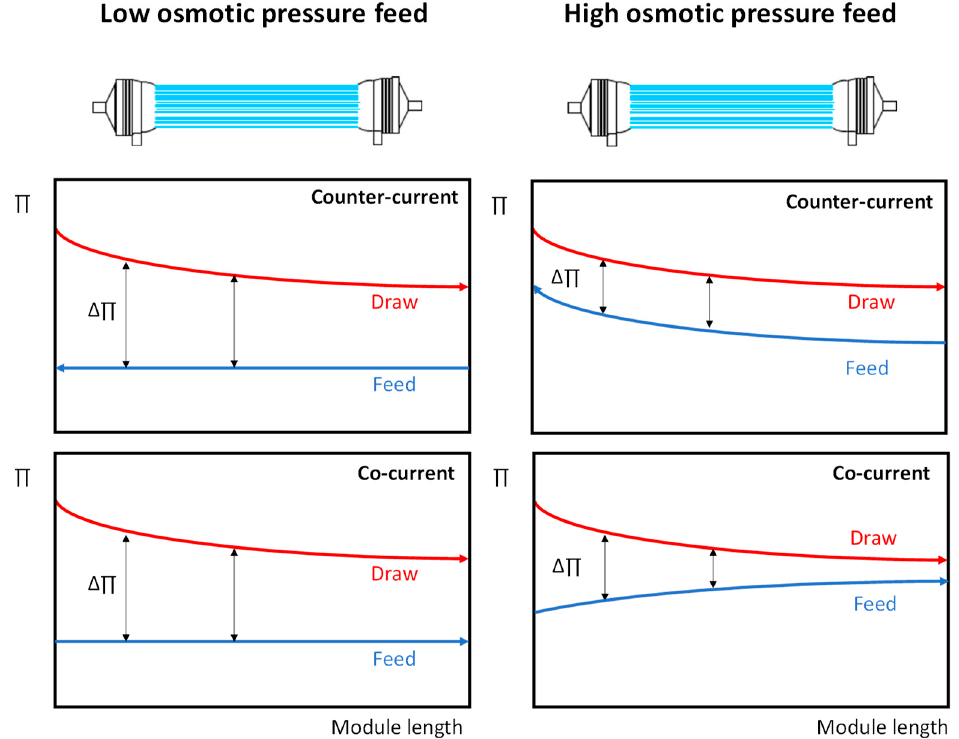
Figure 11. Schematic description of the osmotic pressure development for FS and DS in an HFFO module when operated in a counter-current and co-current mode with low and high osmotic pressure